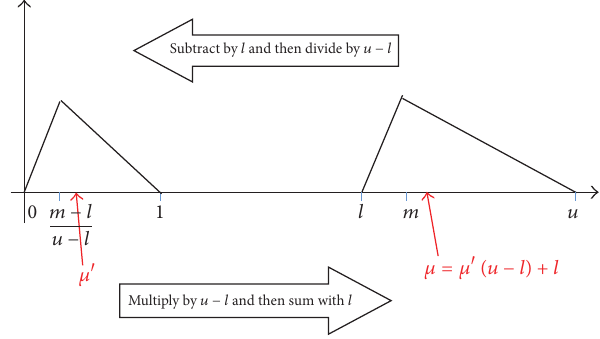
Figure 2: Transfer of the triangular fuzzy number to the interval (0, 1) and vice